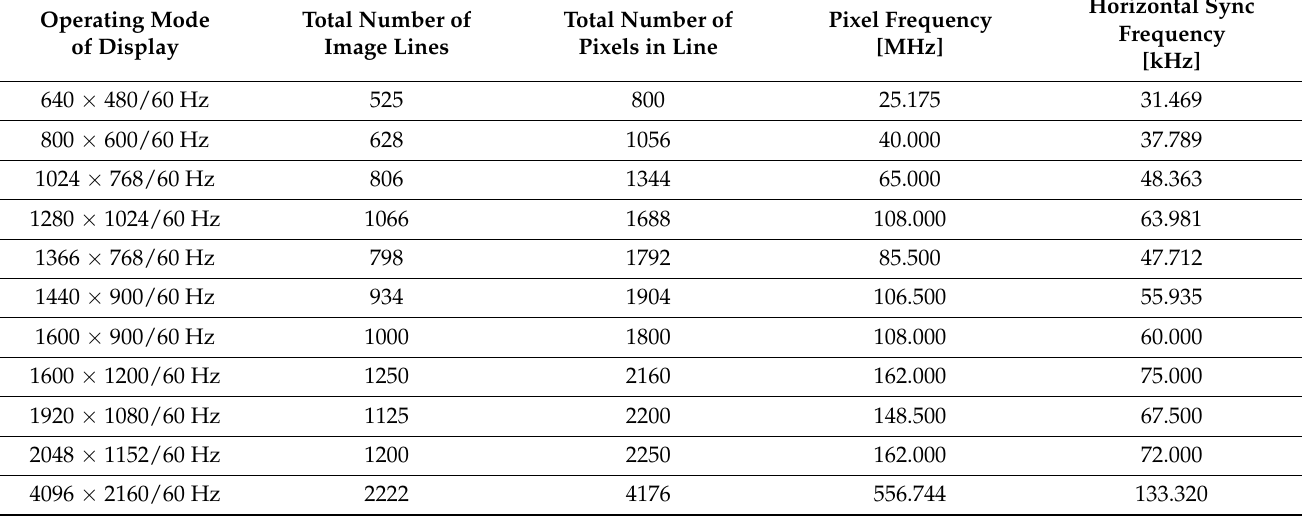
Table 1. Catalog parameter values of the rasterization for selected monitor operating modes (Data from